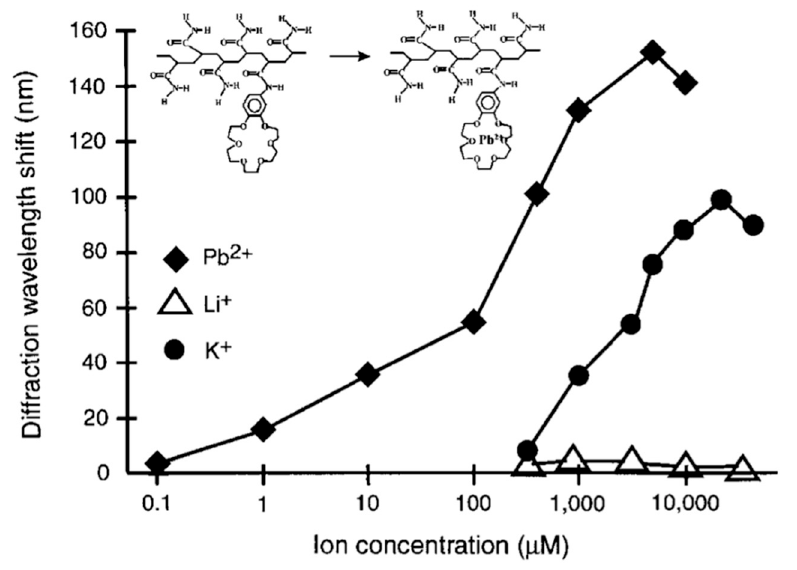
Figure 6. Diffracted wavelength of a polymerized crystalline colloidal arrays (PCCA) sensor as a function of cation concentrations [21]. Reproduced from [21] with permission. Copyright (1997) Springer Nature.